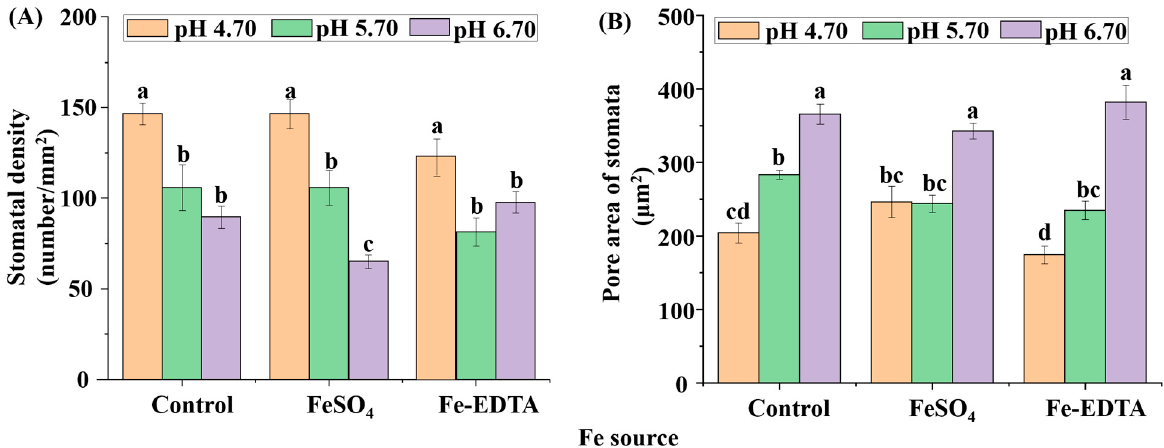
Figure 4. The SEM images of the stomata of H. macrophylla leaves after 60 days of culture. The bar indicates 50 µm.